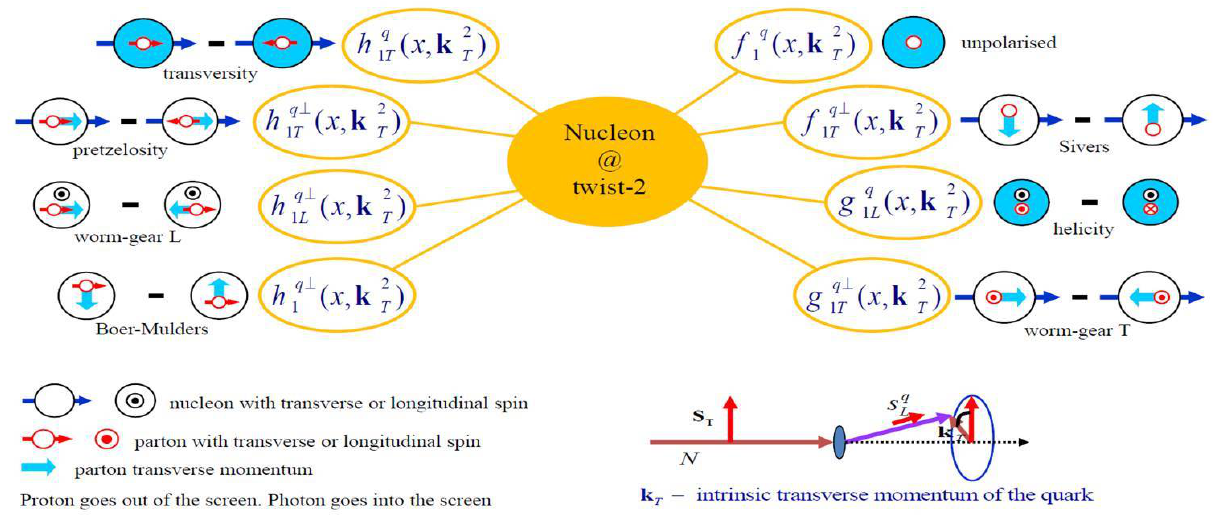
Figure 1. Nucleon description at leading twist when k ⊥ is considered